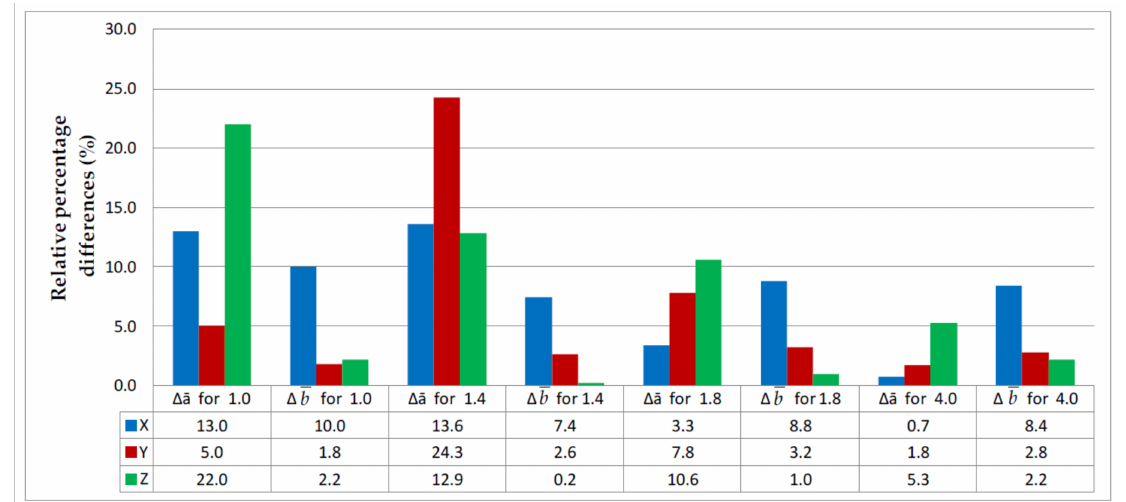
Figure 21. Relative differences in thickness and width between the PLA specimens, where X, Y and Z are printing